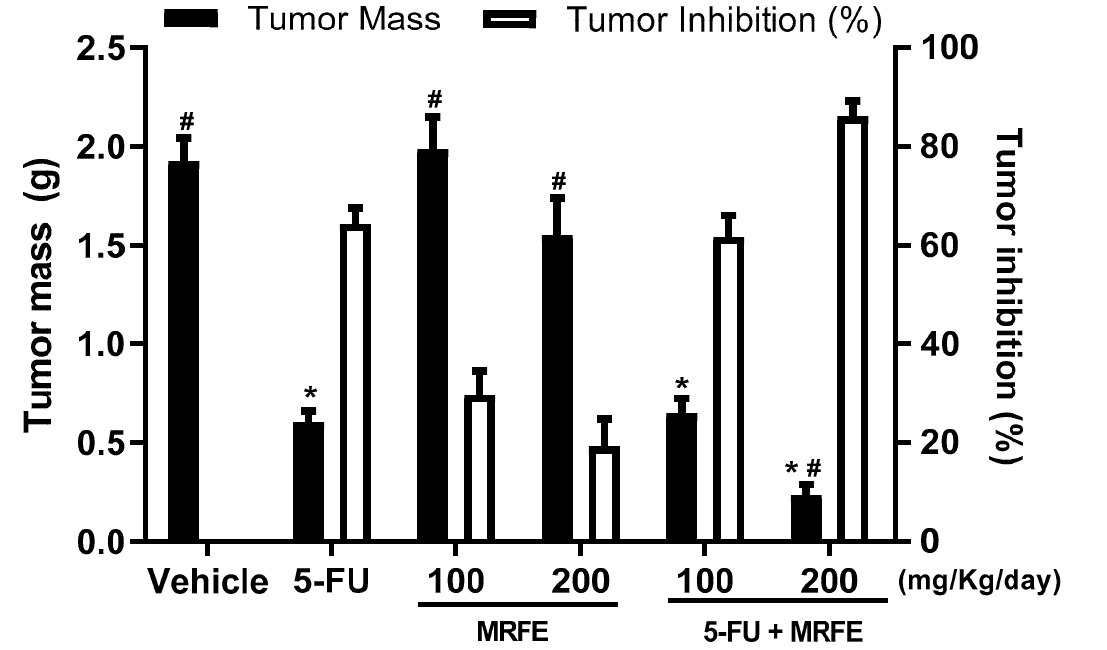
Figure 1. In vivo antitumor effect of 5-FU 25 mg/kg/day associated with MRFE 200 mg/kg/day in animals transplanted with sarcoma 180. The vehicle group was treated with saline and the 5-FU group with 5-Fluorouracil 25 mg/kg/day. The values correspond to the mean ± S.E.M. of 07 animals/group analyzed using one-way analysis of variance with the Student–Newman–Keuls post test. * p < 0.05 compared to the vehicle group. # p < 0.05 compared to the 5-FU group.